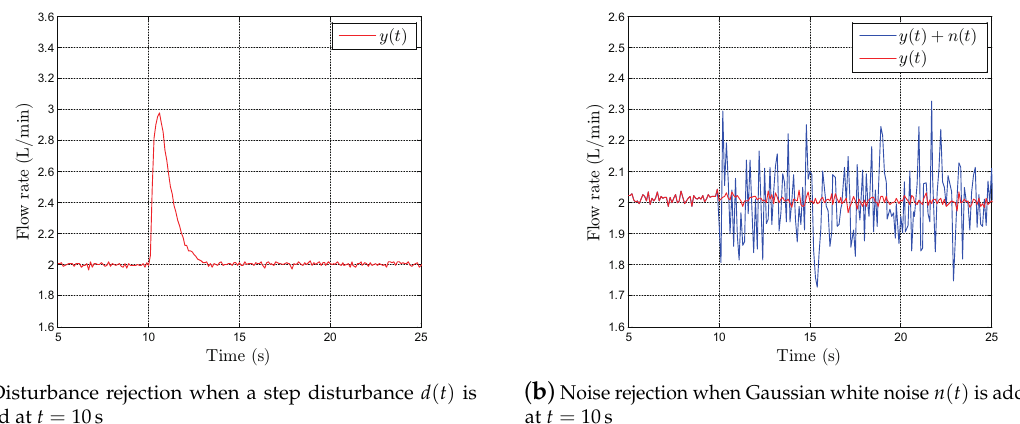
Figure 17. Robustness validation of the feedforward plus feedback control system integrated in parallel